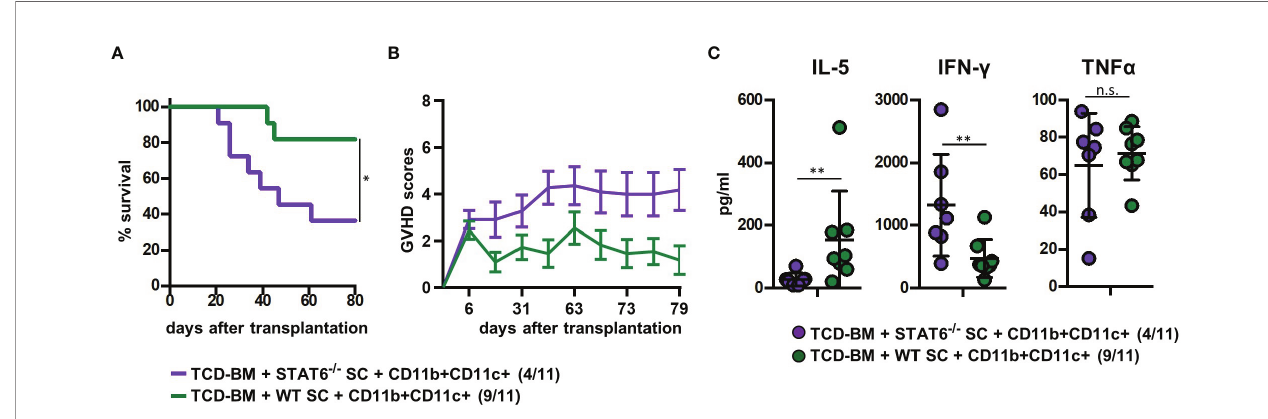
FIGURE 5 | Type 2 immune induction by cotransplanted CD11b+CD11c+ MDSCs is required for GVHD prevention. Lethally irradiated B6.bm1 (H-2K bm1 ) recipient mice were reconstituted with B6-dervied (H-2K b ) T-cell-depleted bone marrow (TCD-BM) and SCs either derived from B6 wild-type (WT) mice (H-2K b ) or STAT6 − / − mice (H-2K b ). B6-derived (H-2K b ) CD11b+CD11c+ MDSCs were cotransplanted at day of transplantation. (A) Survival and (B) GVHD scores were analyzed. Surviving animals/total animals treated are indicated in brackets. (C) Ten days after transplantation, serum cytokine concentrations of Th2- (IL-5) and Th1-associated (IFN- g and TNF- a ) cytokines were determined. (A) Data represent the mean value ± SEM. (B) Kaplan-Meier method and Log-rank test. (C) Mann-Whitney U test. * p ≤ 0.05; ** p ≤ 0.01; n.s., not signi fi